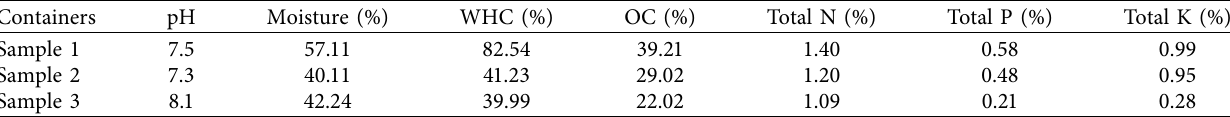
Table 2: Chemical profile of vermicompost made by Aporrectodea caliginosa (field